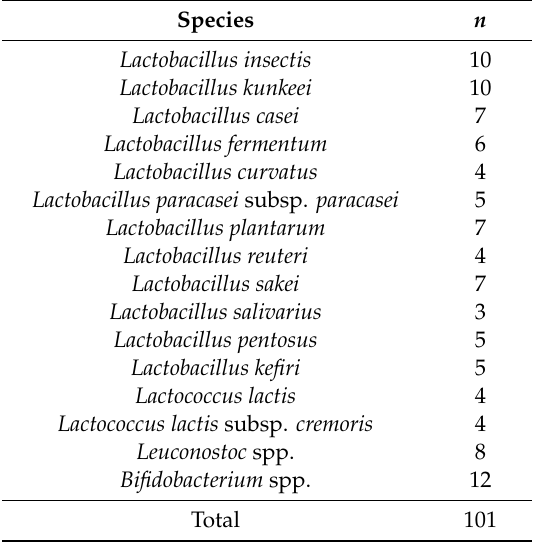
Table 1. Isolated species of lactic acid bacteria (LAB) and Bifidobacterium spp. From the oregano honey honeycomb.